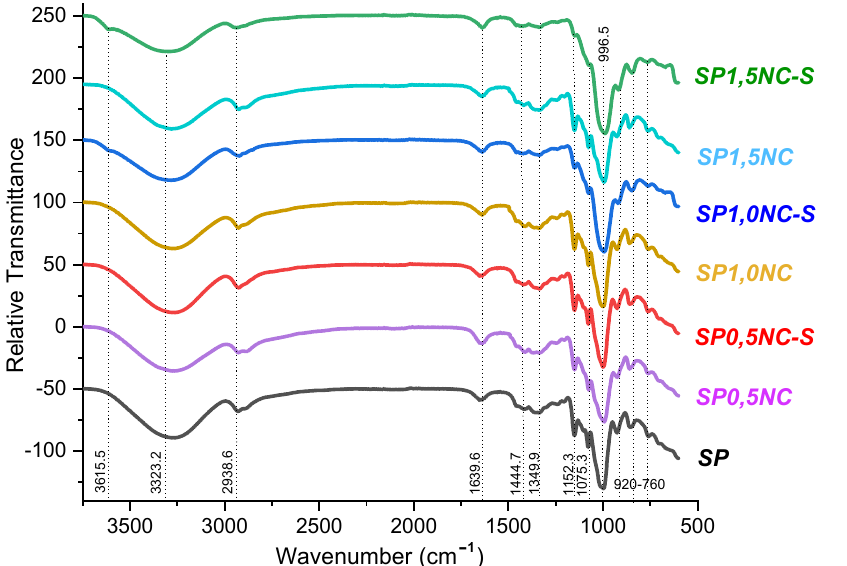
Figure 4. FT-IR spectra of bionanocomposite SP films at different concentrations of MMT clay and ultrasound treatment.